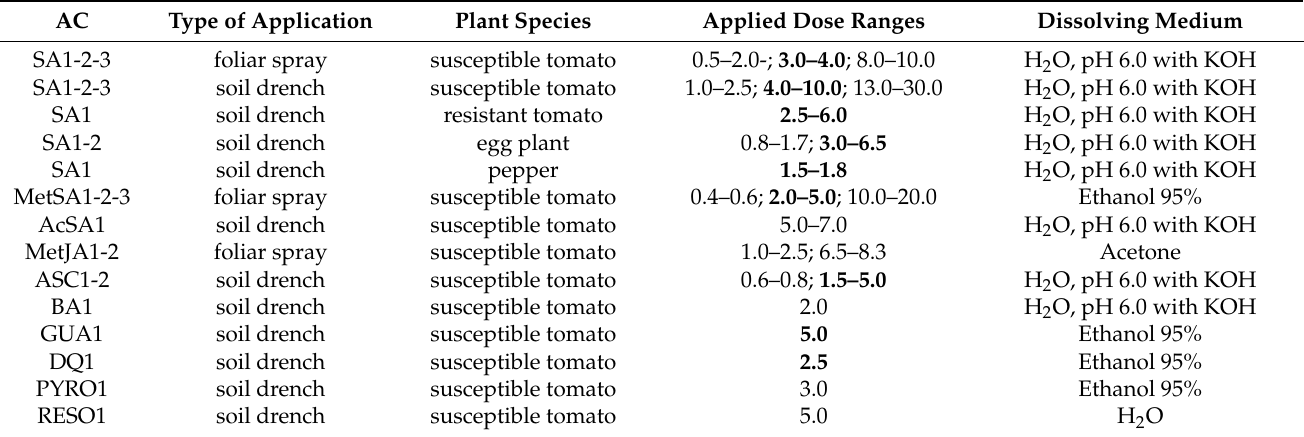
Table 1. Antioxidant compounds (ACs) used in the treatments, type of application, plant species to which treatments were applied, dose ranges, expressed as mg g − 1 pfw (plant fresh weight at treatment), and type of dissolving medium for compounds soluble and insoluble in water. In bold, dose ranges able to inhibit nematode infection without costs or with acceptable costs to plant